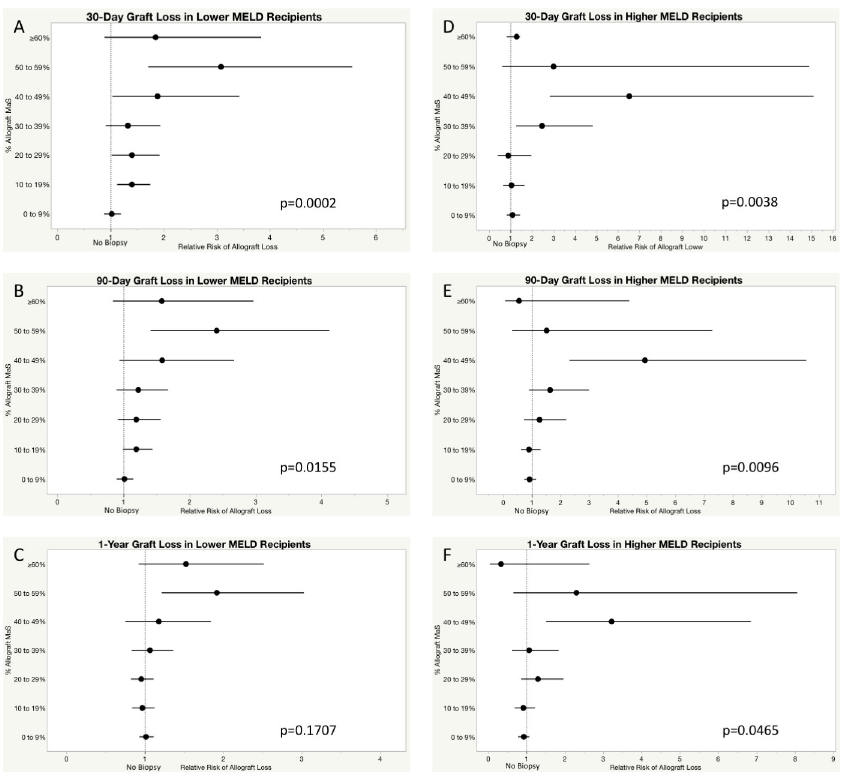
Fig 3. Relative risk of graft loss compared to organs without donor liver biopsy. Forest plot representing the relative risk of allograft loss determined by multivariable logistic regression models. Risk of graft loss in Lower MELD recipients at A) 30 days, B) 90 days, C) 1 year; risk of graft loss in Higher MELD recipients at D) 30 days, E) 90 days, and F) 1 year.